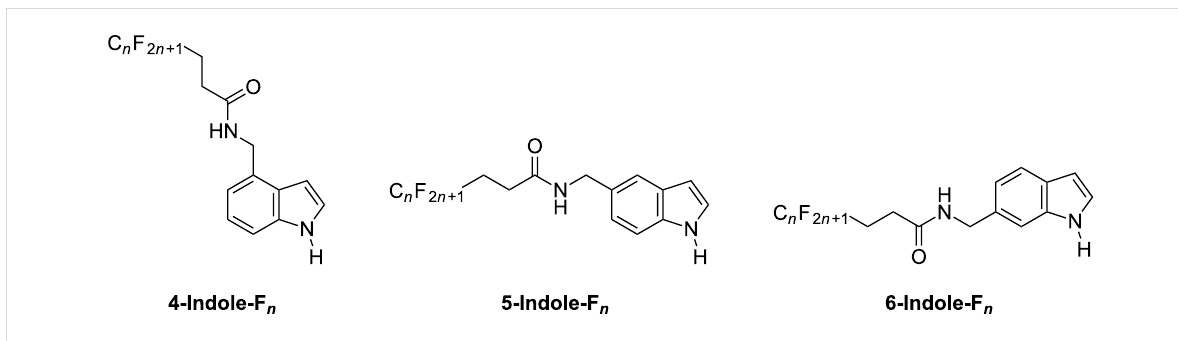
Scheme 1: Original indole monomers synthesized and used in this manuscript.